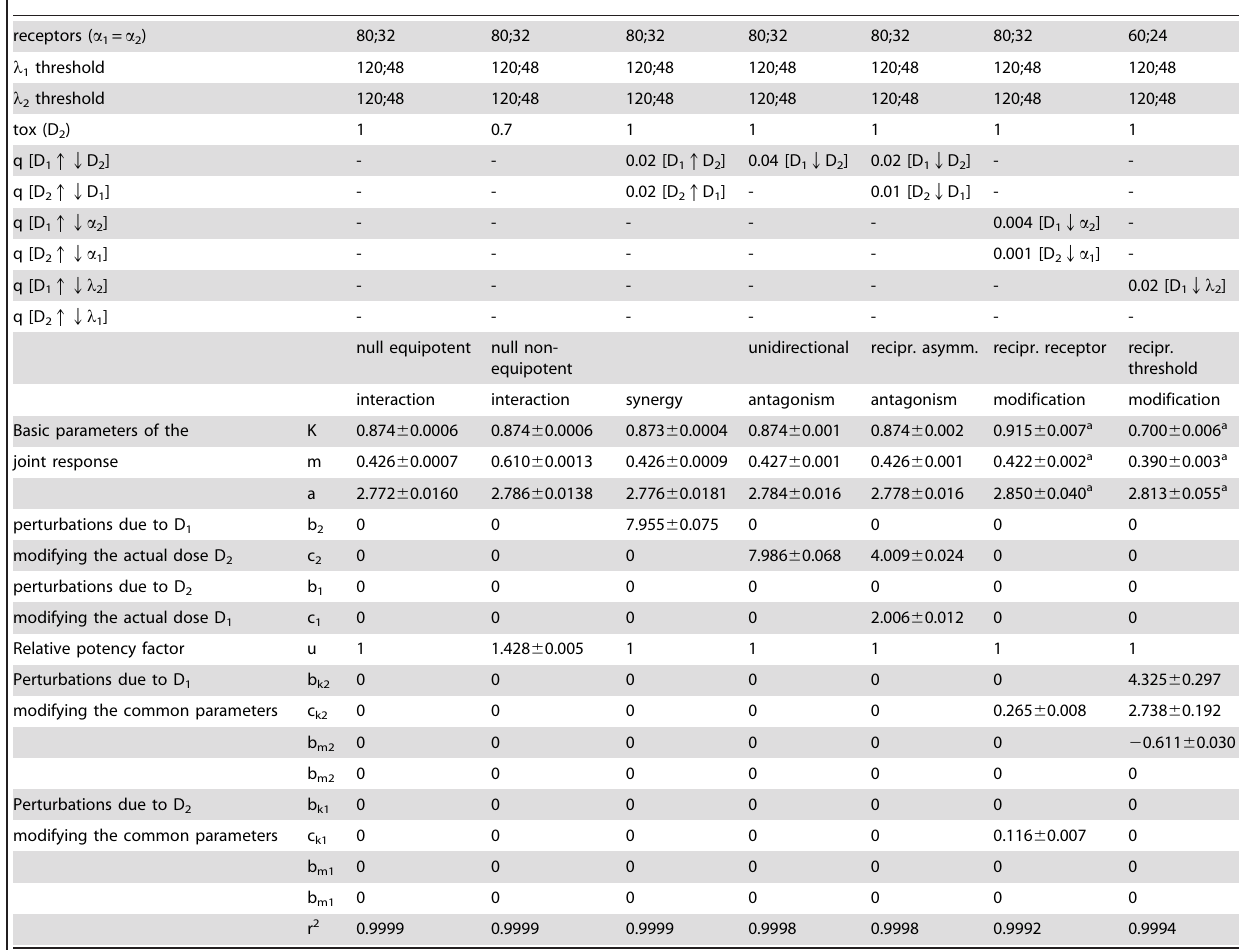
Table 5. Simulation conditions and respective fittings ( a =0.05) to the generalized CA model in the specified examples.